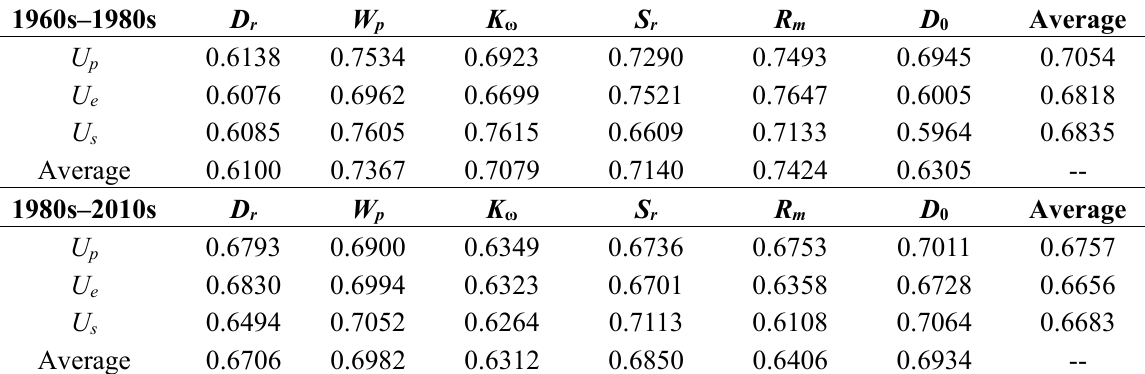
Table 3. The grey relational degrees between the changes in river indicators and urbanization